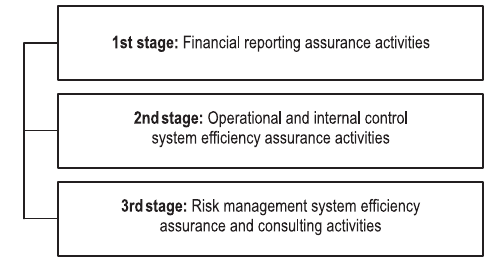
Fig. 1. Internal audit activities – evolution